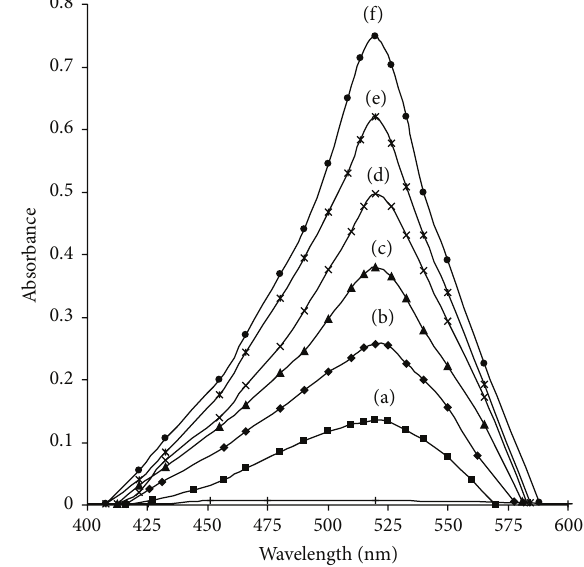
Figure 2: Absorption spectra of the oxidation product against blank with different concentration of PZT: (a) 1.0, (b) 2.0, (c) 3.0, (d) 4.0, (e) 5.0, and (f) 6.0 𝜇 gmL −1 , 1.0mL of 5.0 M HCl, 1.5mL of KBrO 3 (100 𝜇 gmL −1 ), and 1.5 mL of 5.0 × 10 −4 mol L −1 methyl orange